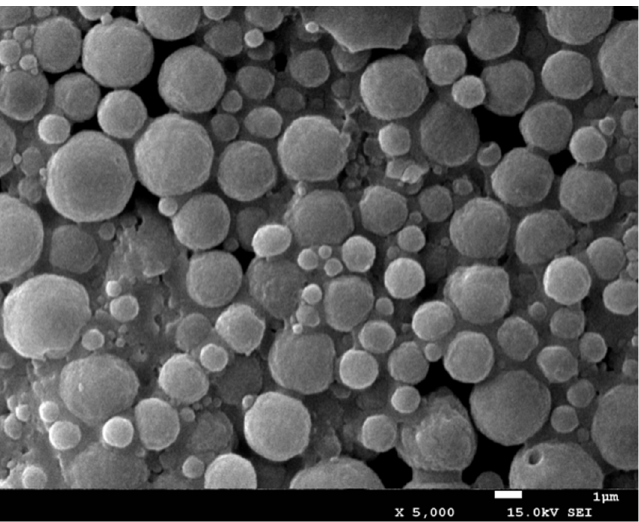
Figure 3. Morphology of MAN-CS-OVA-PLGA-MPs visualized by scanning electron microscopy.